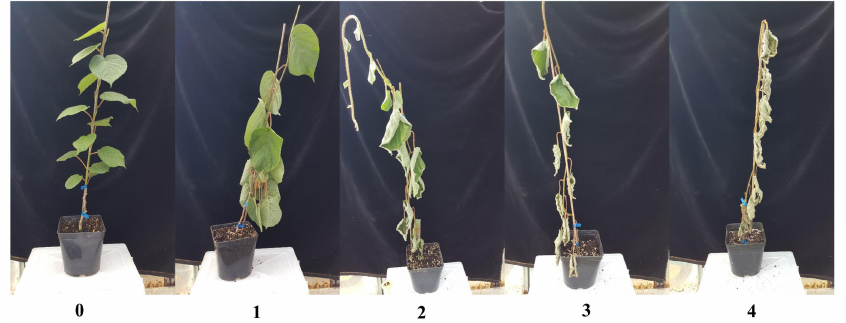
Figure 1. Disease severity index used to evaluate in greenhouse the pathogenicity of the Phytopythium species inoculated on 1-year-old A. chinensis var. deliciosa ‘Hayward’ plants. To fulfil Koch’s postulates, re-isolations were performed from the roots of all the plants and the isolates were identified by sequencing the COI gene, as described above.